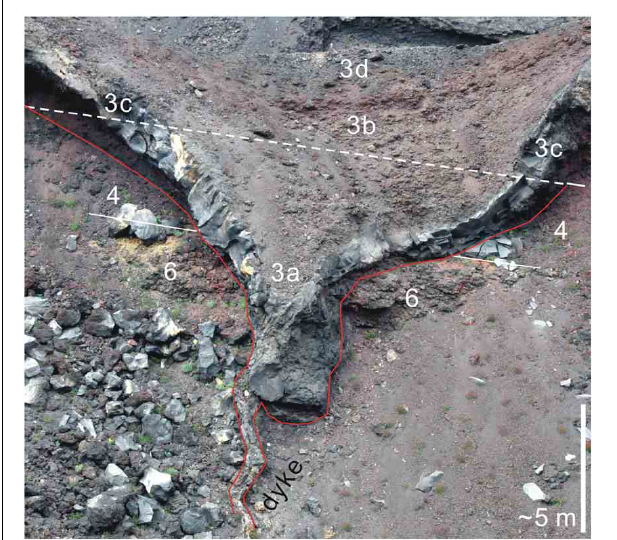
FIGURE 6 | Close-up view of the feeder system on the northern wall of the 1809 crater A (outcrop A–N). The outlines of the feeder system are highlighted with red lines. White solid lines show the unit boundaries. The dashed line represents the ground surface at the beginning of the 1809 eruption. See text for lithological